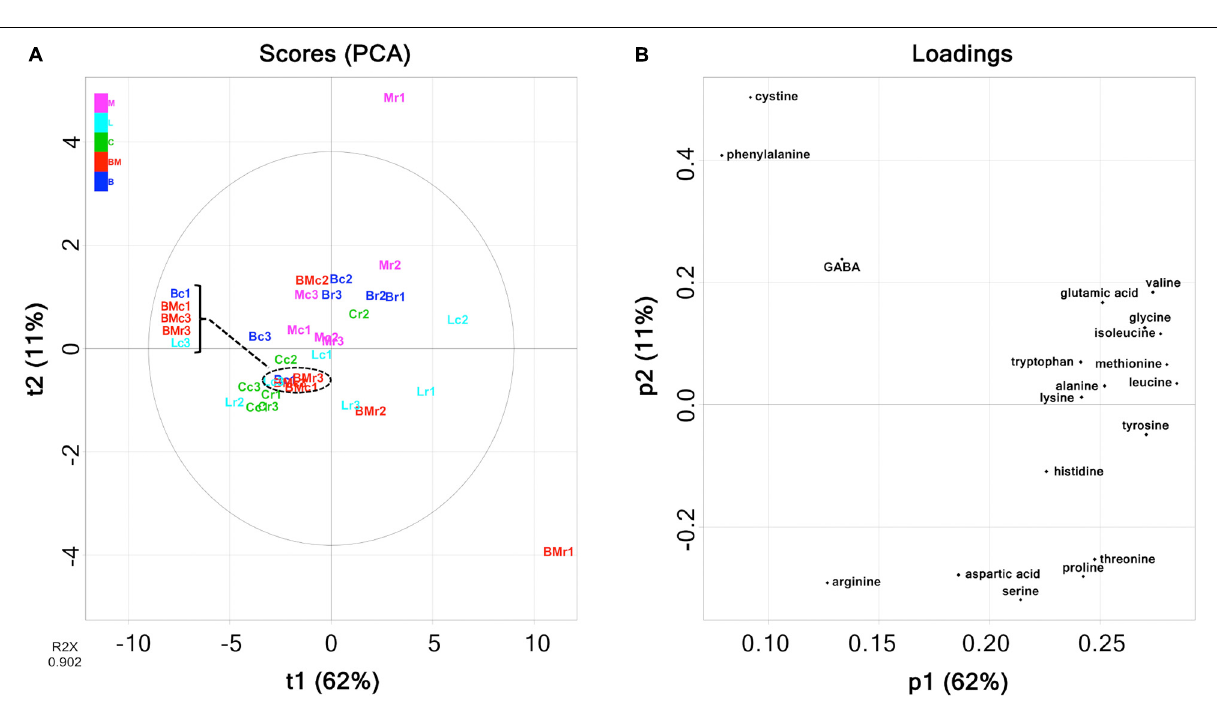
FIGURE 6 | Principal component analysis (PCA) on the abundance of free amino acids in 30 cheese samples. (A) Score plot. (B) Loading plot. Bc, Brie de Meaux core; Br, Brie de Meaux rind; BMc, Brie de Melun core; BMr, Brie de Melun rind; Cc, Coulommiers core; Cr, Coulommiers rind; Lc, Langres core; Lr, Langres rind; Mc, Maroilles core; Mr, Maroilles